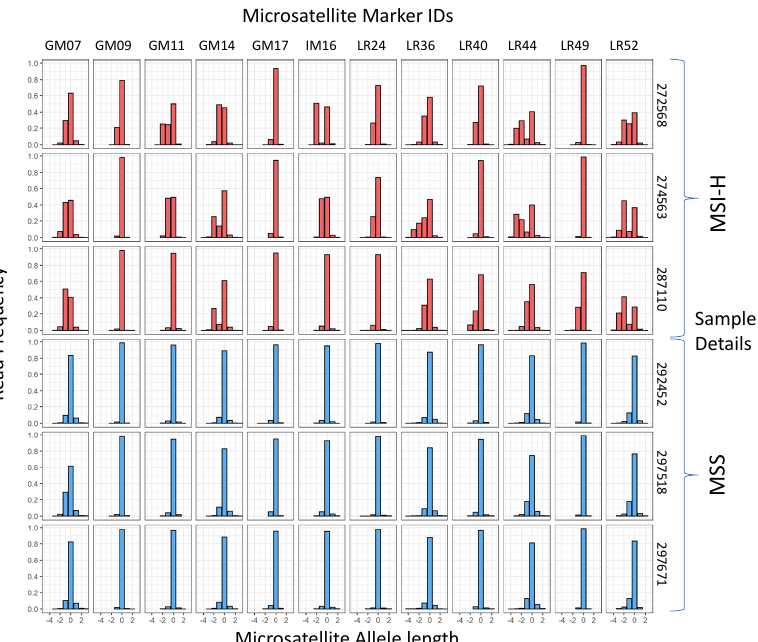
Figure 1. Microsatelllite allele length frequencies in training samples with known MSI status. The reference allele length is 0 for each marker. Sample classification, marker names, and sample numbers are shown.